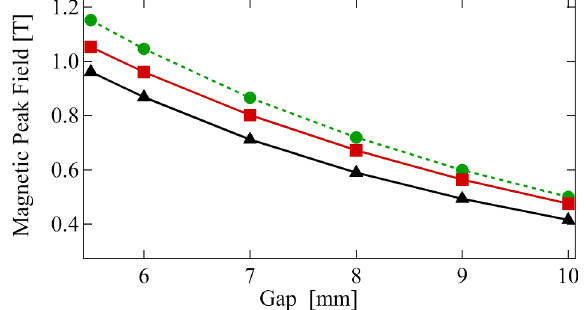
FIG. 2. On-axis magnetic peak field calculated with RADIA.